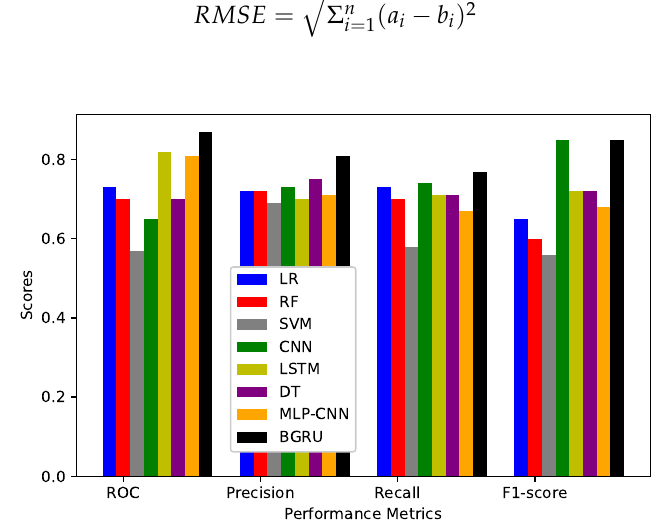
Figure 12. Comparison of BGRU with other